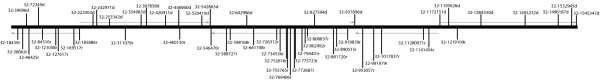
Genomic organization of SIDER2 elements in the L. infantum chromosome 32. The position and the orientation of the elements were deduced from the sequence of contig LinJ32_20070420_V3 [25]. The extent and directions of the transcriptional units are denoted by horizontal grey arrows. See table 1 for further details of the SIDER2 elements mapping to this chromosome.